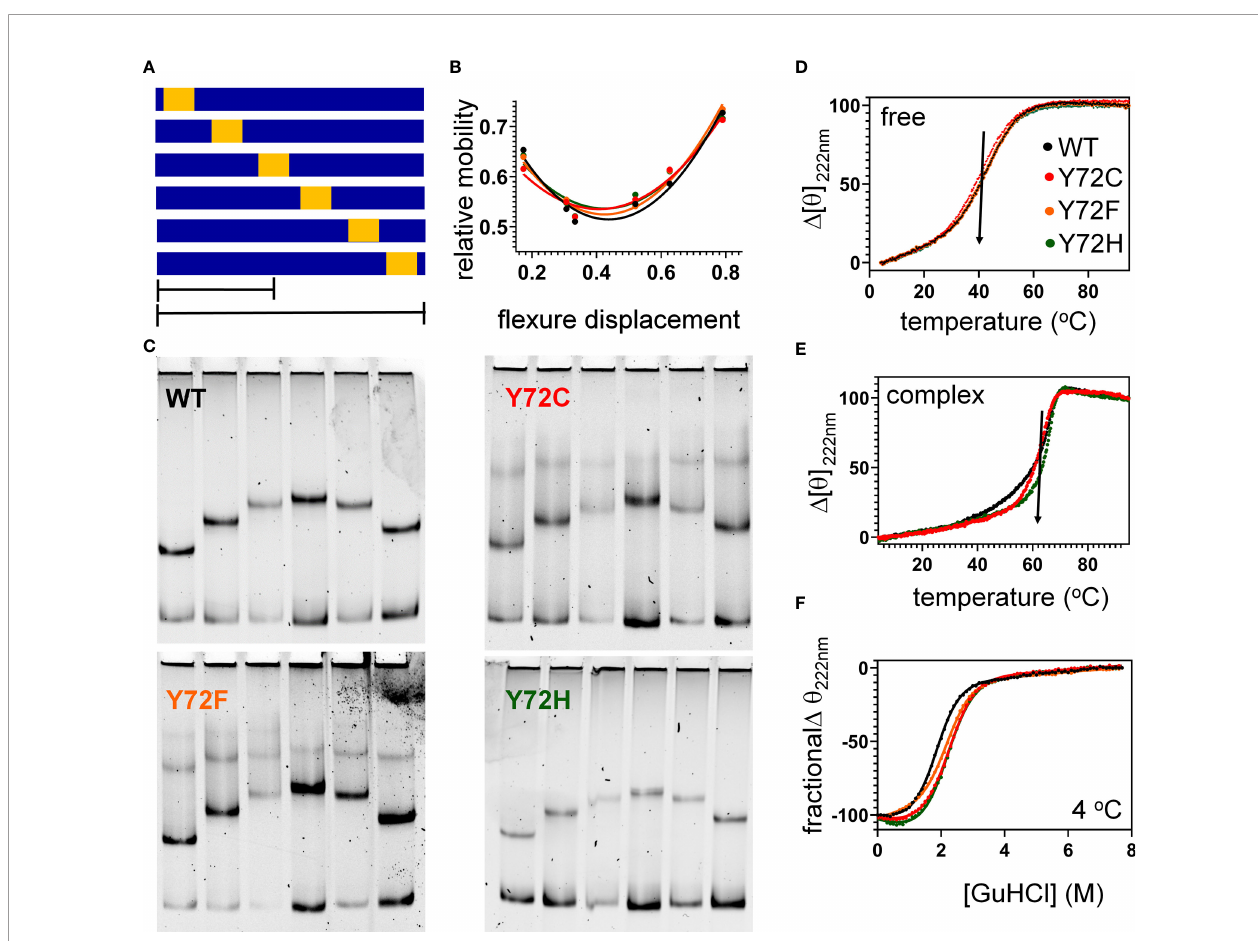
FIGURE 7 | Protein-directed DNA bending. (A) Schematic representation of set of six DNA fragments used in permutation gel electrophoresis (PGE) (83). Golf region indicates position of SRY target site (core element 5 ’ -ATTGTT-3 ’ and complement). Flexure displacement (designated by the two black lines) is the determined by dividing the number of base pairs from 5 ’ -end to the center of the 5 ’ -ATTGTT-3 ’ motif by total number of base pairs in the fragment (150 bp). (B) Relationship between fl exure displacement (horizontal axis) and relative mobility for the WT or variant SRY domains (color code as inset in D ). (C) Representative gels indicating that sharp DNA binding is retained for all variant domains with some attenuation in bend angle (see Table 1 ). (D, E) Thermal unfolding curves of free domains (D) and corresponding speci fi c DNA complexes ( E ). Whereas the free domains indicate similar midpoint unfolding temperatures (T m ) (near 40 °C; black arrow), the speci fi c domain-DNA complexes are more resistant to thermal unfolding but exhibit different high-temperature behaviors. (F) Chemical denaturation studies of the free domains: CD-de fi ned ellipticity at helix-sensitive wavelength 222 nm (vertical axis) was measured as a function of guanidine-HCl (horizontal axis); see Table 1 for results of two-state thermodynamic modeling